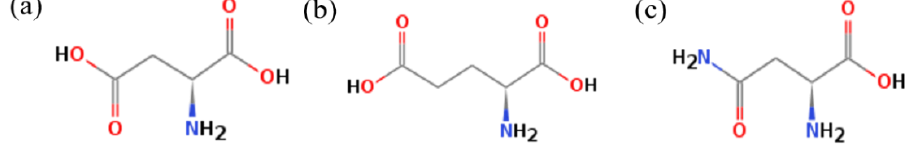
Figure 5. Molecular structural formulas of ( a ) L-Asp, ( b ) L-Glu, and ( c ) L-Asn.